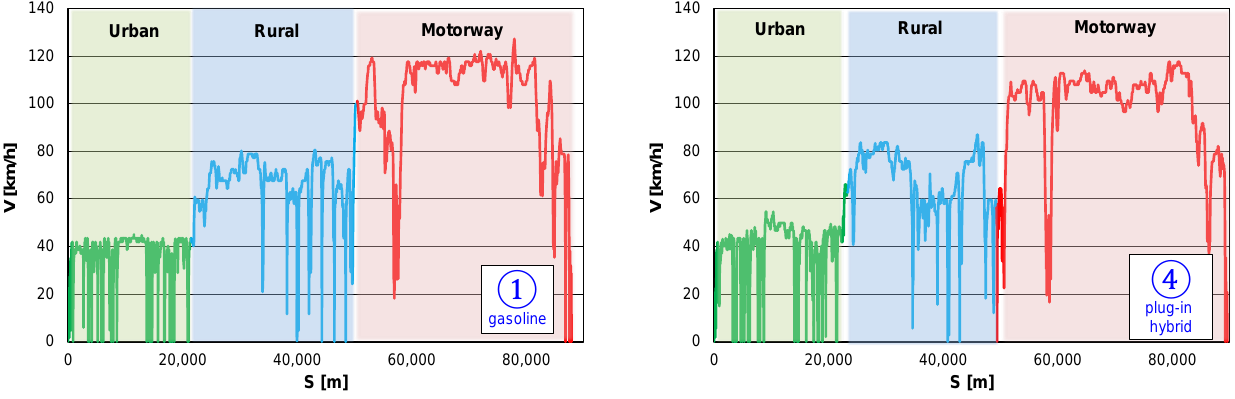
Figure 5. Implementation of the RDE test for vehicles 1 and 4 — the course of speed as a function of distance; 1 — gasoline, 4 — plug-in hybrid.